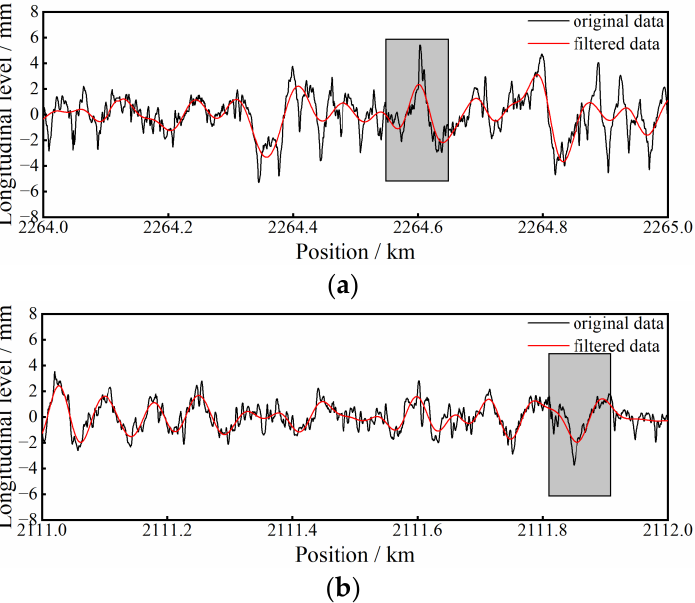
Figure 10. Samples of incorrectly classified waveforms: ( a ) sample of FP; ( b ) sample of FN.